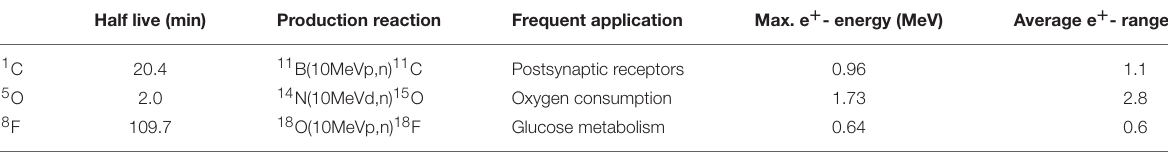
TABLE 1 | PET isotopes produced by high energy protons in a cyclotron accelerator. Half live (min)